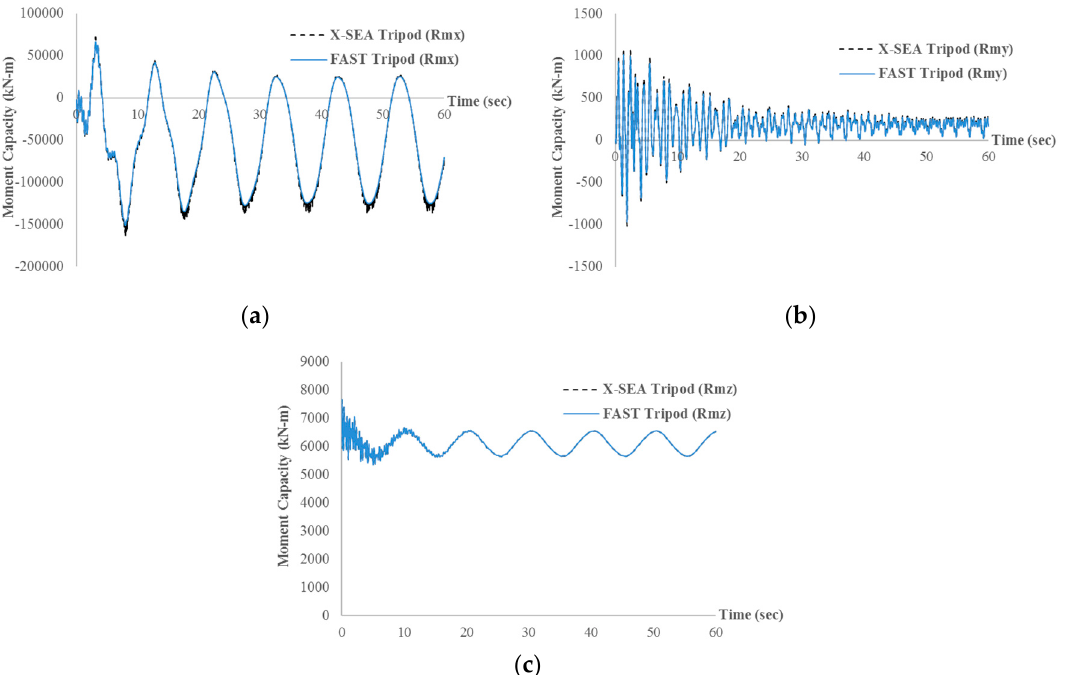
Figure 9. A comparison of the dynamic reaction moments of the tripod support structure that resulted from X-SEA and FAST programs in the x-direction ( a ), y-direction ( b ), and z-direction ( c ).